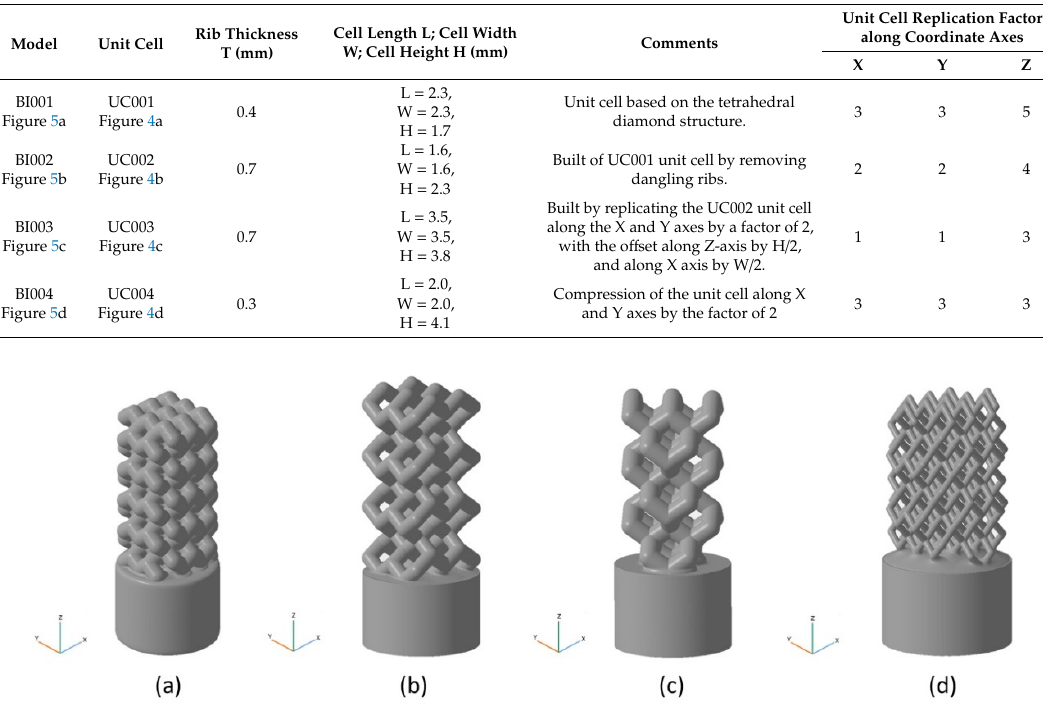
Table 1. Implants modeling parameters.